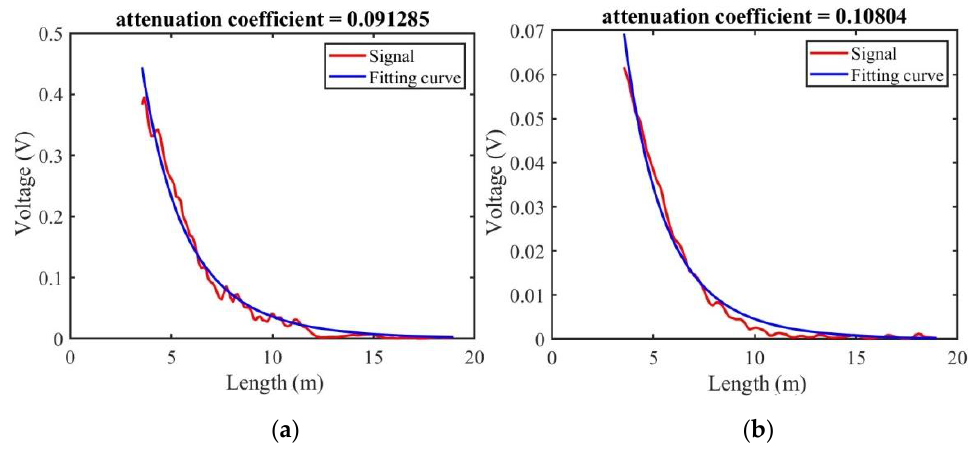
Figure 11. Calculation of the attenuation coefficient of water: ( a ) fitting result for the total scattering energy; ( b ) fitting result for the Brillouin scattering energy.